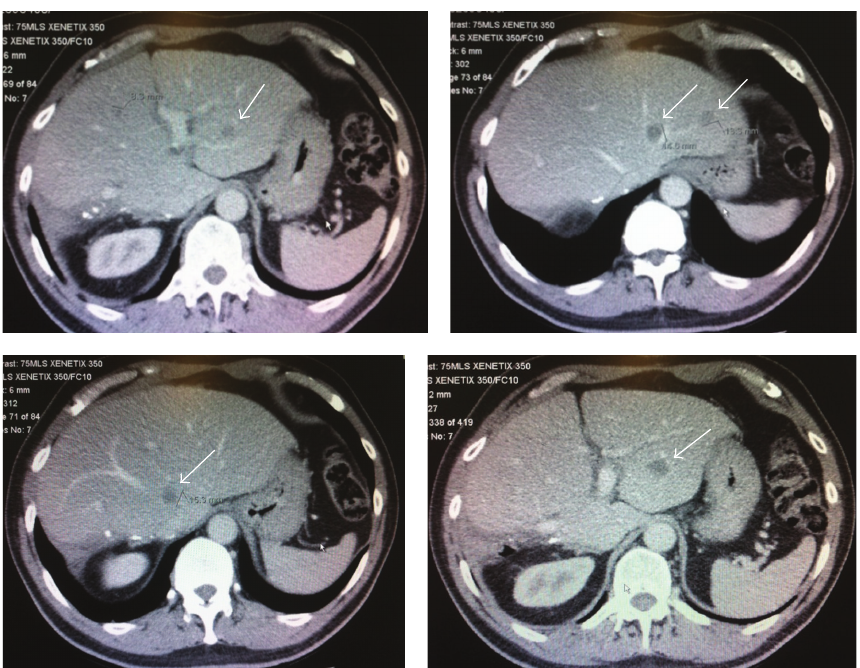
Figure 2: Recurrent unresectable liver metastases following right hepatectomy. Five new liver metastases (white arrows) in the remnant liver (Seg II, III, and IV).